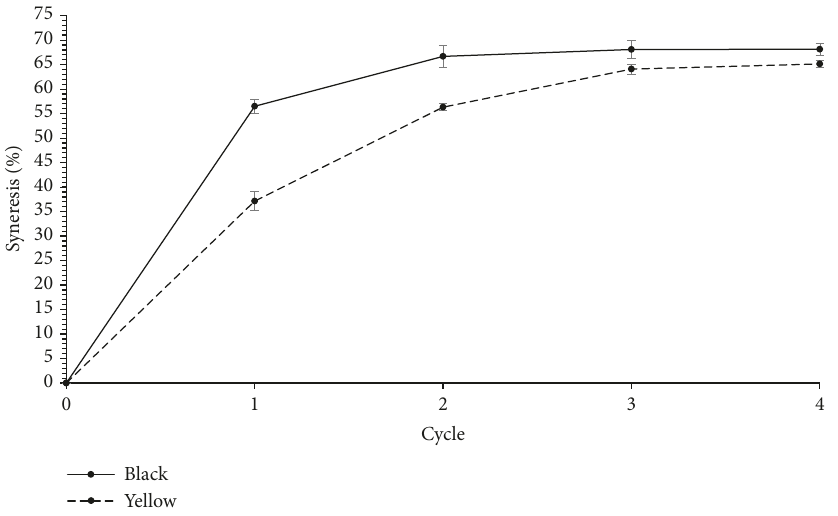
Figure 2: Freeze-thaw stability of starch gels from yellow and black